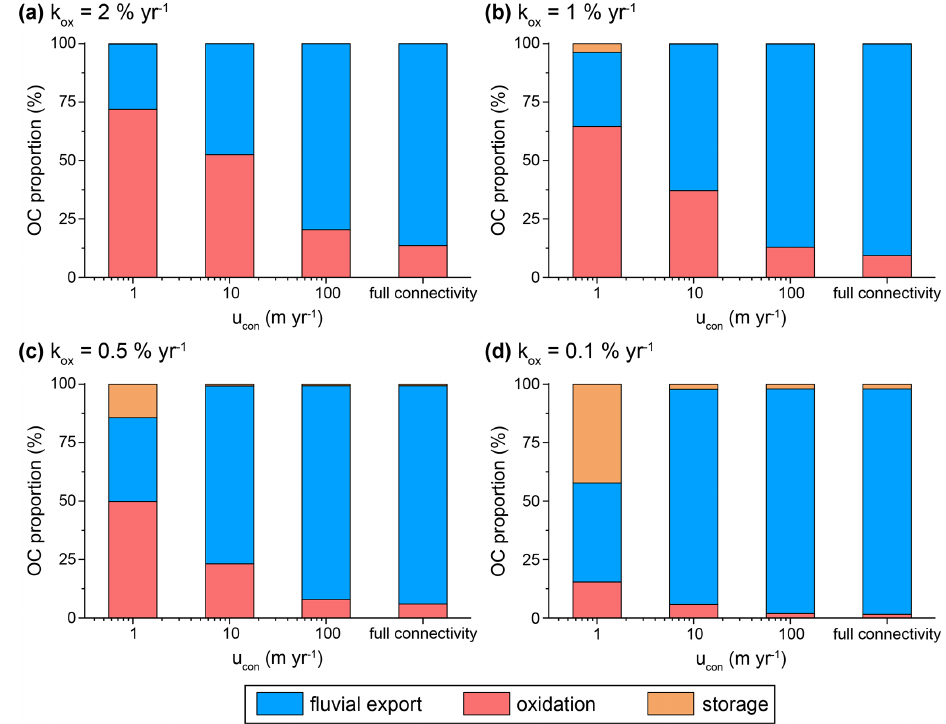
Figure 6. Histograms showing the fate of the landslide-mobilized OC at the end of a seismic cycle with a duration of 270 years partitioned between fluvial export, oxidation and landslide deposit storage. These results have been computed with the single pool model for different connection velocities and different oxidation constants: (a) k ox = 2%yr − 1 ; (b) k ox = 1%yr − 1 ; (c) k ox = 0 . 5%yr − 1 ; (d) k ox = 0 . 1%yr − 1 .